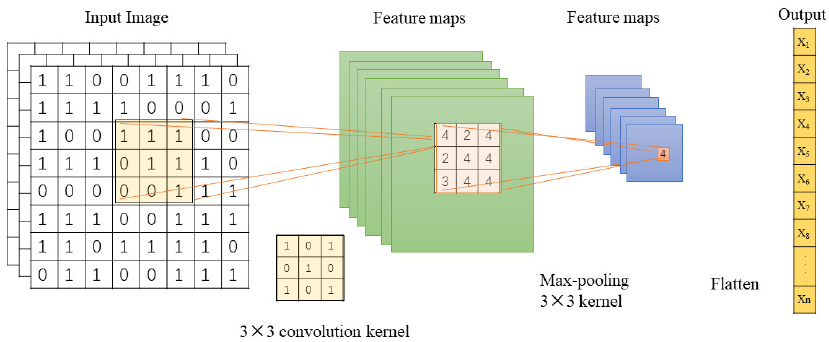
Figure 4. The Convolution Process.